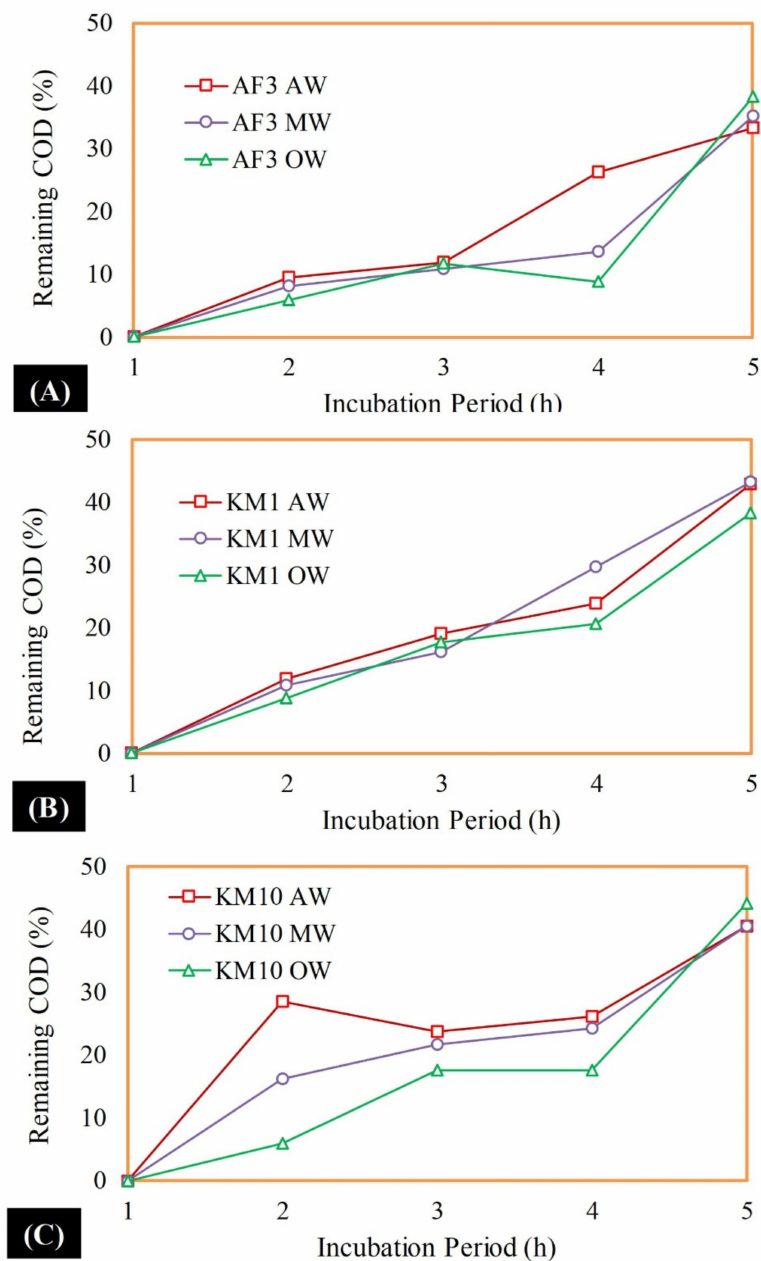
Figure 2. COD (mg O 2 /L) removal from different waste types during aerobic biodegradation of the waste slurry by different bacterial strains; ( A ) AF3 strain, ( B ) KM1 strain, ( C ) KM10 strain. Similarly, the potential of KM1 for lipid accumulation with simultaneous waste degra- dation and their interrelationship is presented in Figure 4A–F. Lipid accumulation (25.4%) was maximum in KM1 using MW as substrate (Figure 4D). The interaction plots again represented a strong association of lipid accumulation with the process duration; however, this performance is limited up to 96 h only afterwards the lipid accumulation started to decline. This could be clearly observed by the depression at 96 h of incubation of surface plots (Figure 4A,C). The accumulation of the lipids can also be found strongly related to the organic matter removal